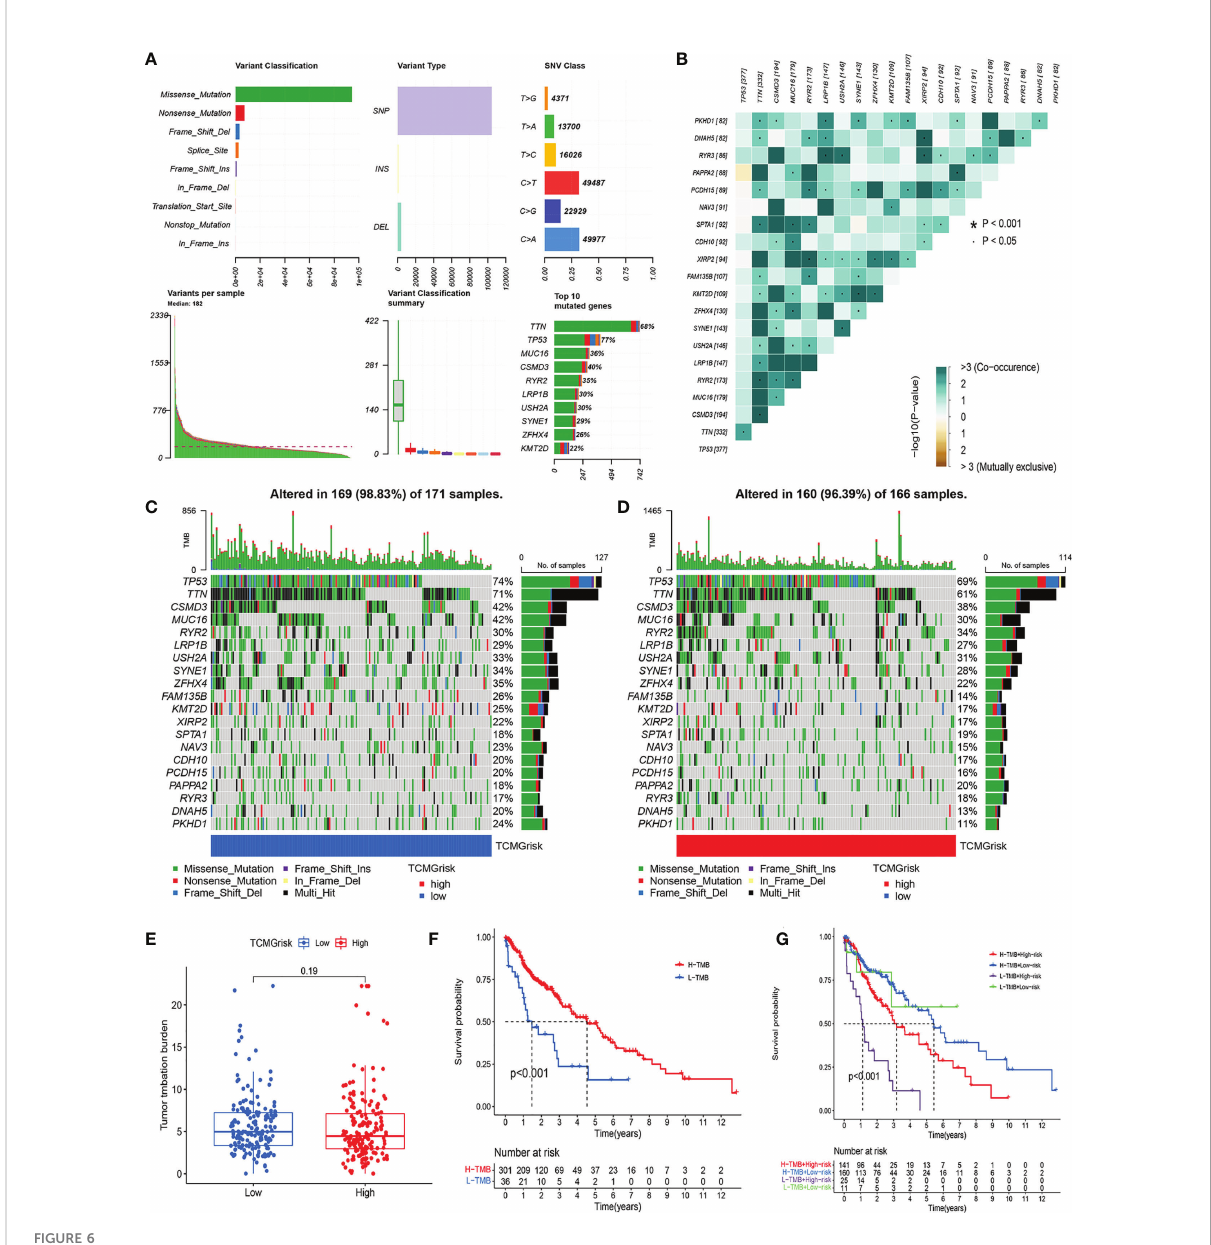
FIGURE 6 Characteristics of somatic mutations. (A) The overall mutation pro fi le of LUSC. (B) Interaction effect of genes mutating differentially in patients in the low-risk and high-risk groups. (C) The mutation frequency of genes in the low-risk group. (D) The mutation frequency of genes in the high- risk group. (E) Differential expression levels of TMB between low-risk and high-risk groups. (F) The Kaplan-Meier curves for the low-TMB and high-TMB groups. (G) The Kaplan-Meier analysis curves for the patients strati fi ed by TCMGrisk and